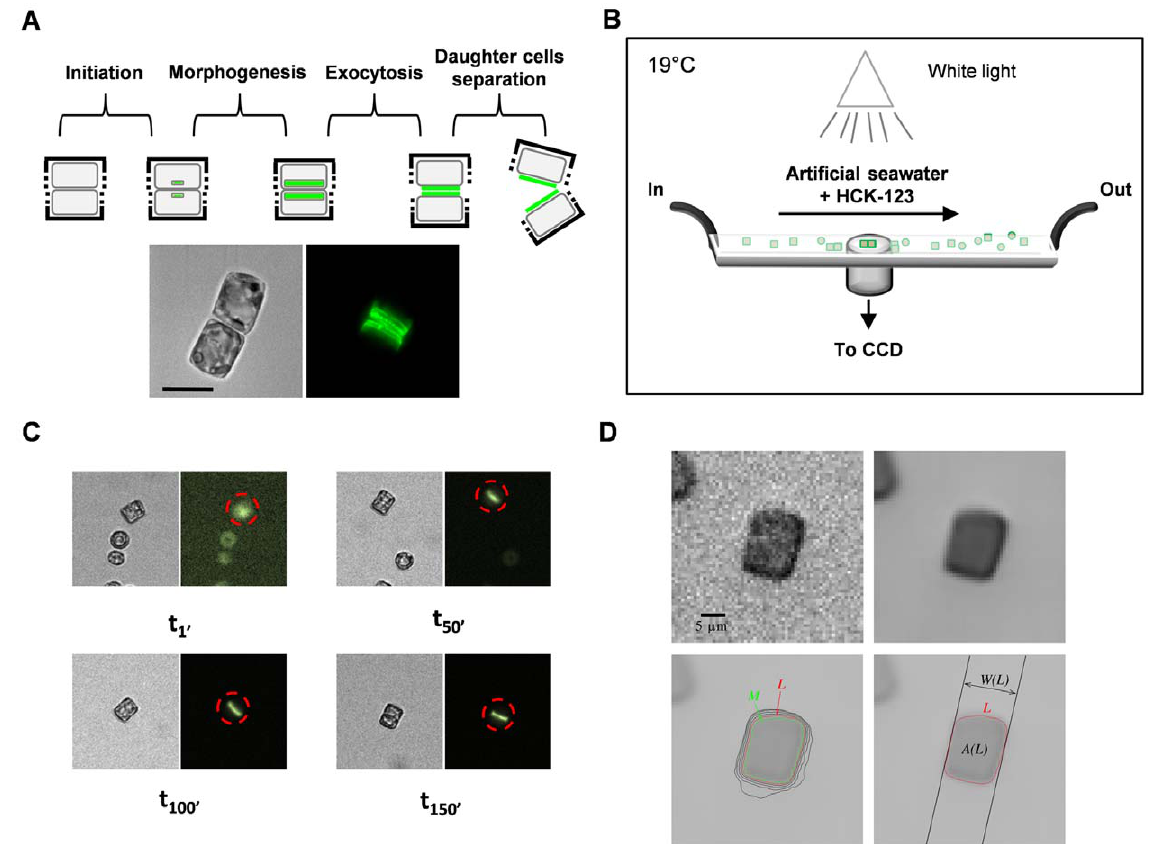
Figure 3. Measurement of valve formation dynamics at the single-cell level. ( A ) The valve formation process can be separated into several phases: an initiation phase, followed by valve formation and morphogenesis, then by valve exocytosis and finally by daughter-cell separation. The two images correspond to the DIC (digital image correlation) and Z-projections of HCK-123 fluorescence ( green ). In green we can visualize newly- synthesized valves labeled with the silica-associated dye (HCK-123). Scale bar ( black ): 10 m m. ( B ) Schematic representation of the microfluidic device used to record valve formation. During valve formation, light intensity, temperature and renewal of the medium were controlled. ( C ) To quantify HCK-123 fluorescence in individual cells, we developed new software for cell-tracking and local background estimation (Methods S1). Images at 4 different times are presented. Apparent cell motility is caused by the liquid flow. ( D ) To precisely quantify fluorescence in each cell we developed a new shape extraction method. The original image was denoised with the TV-means algorithm, leading to a much cleaner image. Then, among the level lines (iso-intensity curves) of the image enclosing the known center of the cell, we considered that the cell boundary was the line with the sharpest contrast ( L ). This enabled us to compute cell area A(L) as the area of the region enclosed by L ), and its width W(L) , defined as the minimum width of a band containing L .